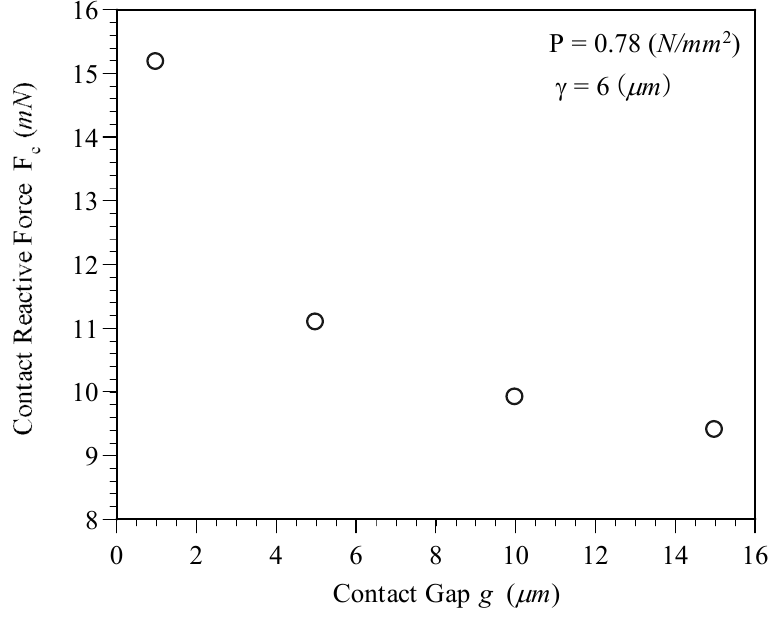
Figure 9. Contact reactive force as a function of the contact